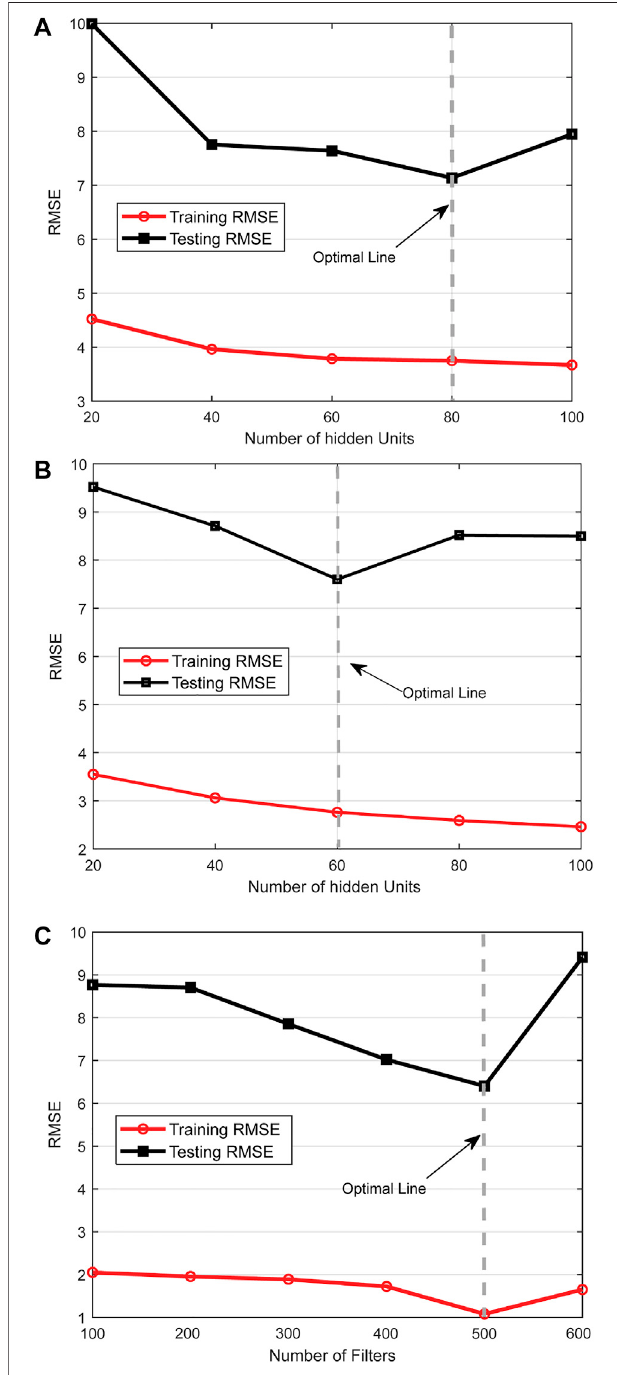
FIGURE 7 | (A) LSTM performance with different hidden units. (B) GRU performance with different hidden units. (C) 1D-CNN performance with a different number of fi